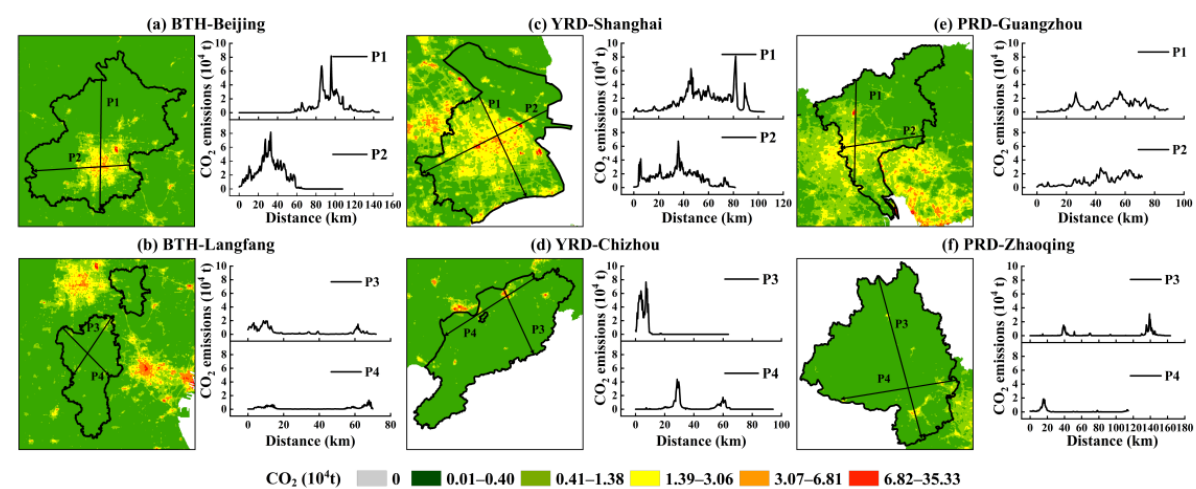
Figure 9. Profiles of CO 2 emissions along urbanization gradients in: ( a ) Beijing; ( b ) Langfang of Bei- jing-Tianjin-Hebei (BTH); ( c ) Shanghai; ( d ) Chizhou of Yangtze River Delta (YRD); ( e ) Guangzhou; and ( f ) Zhaoqing of Pearl River Delta (PRD).